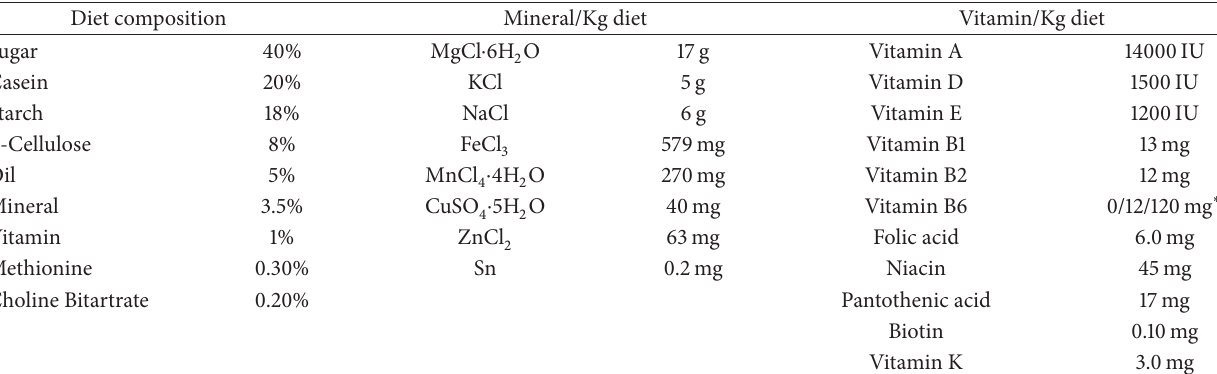
Table 1: Diet composition of vitamin B6 deficient mouse